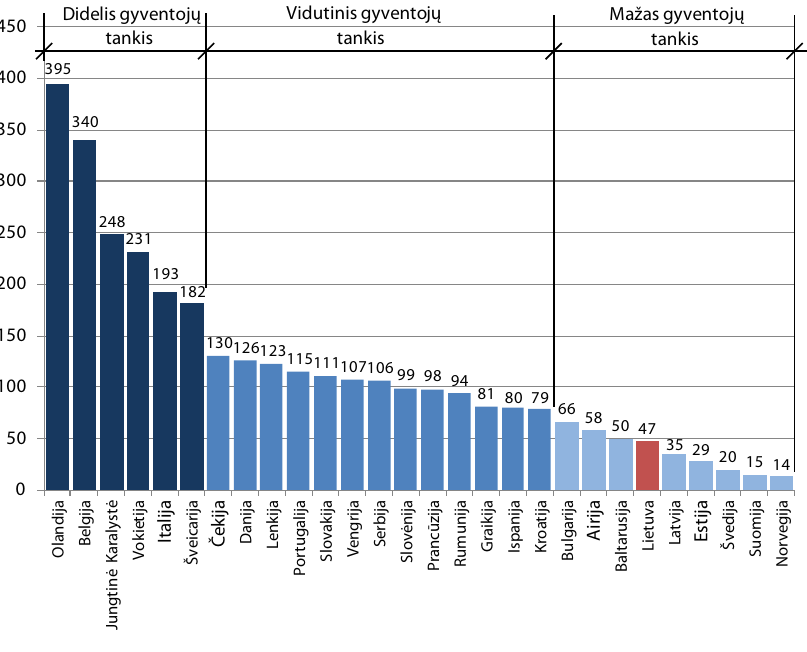
fig. 5. The density of population in European countries (habitants/ km 2